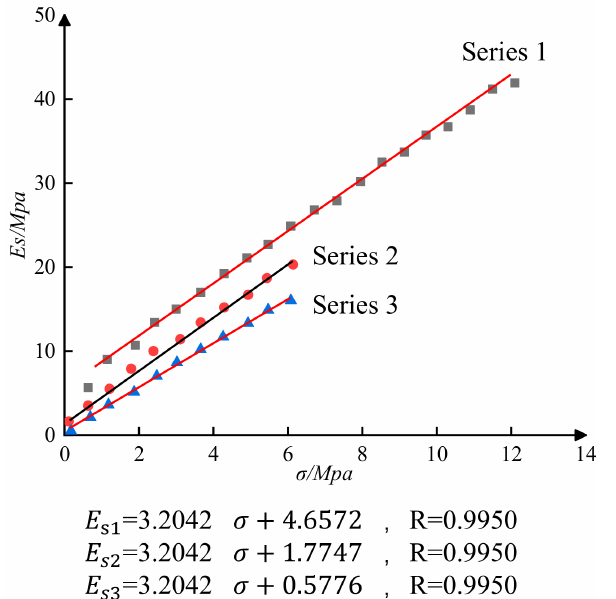
Figure 14. Relationship between the secant modulus and compressive stress of broken rock in different states.